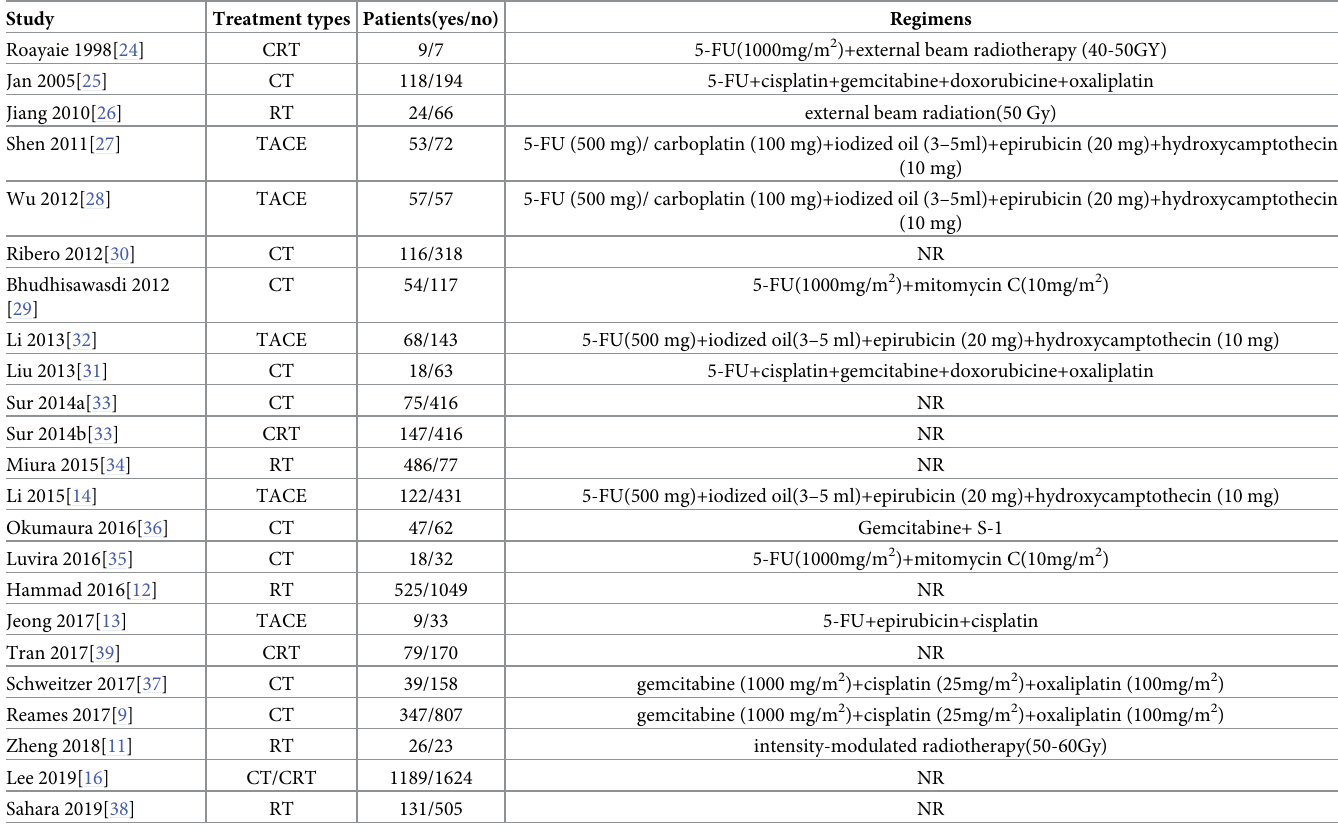
Table 2. Interventions of adjuvant treatments in the included